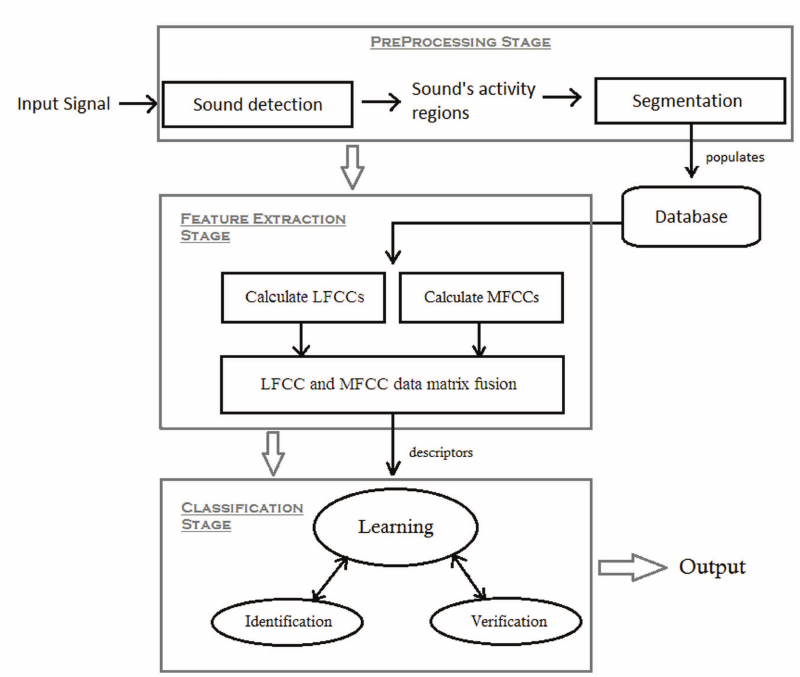
Figure 2. Diagram of the proposed